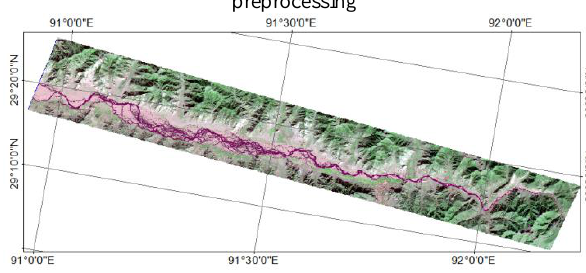
Figure 2. False colour composite image of upstream after preprocessing